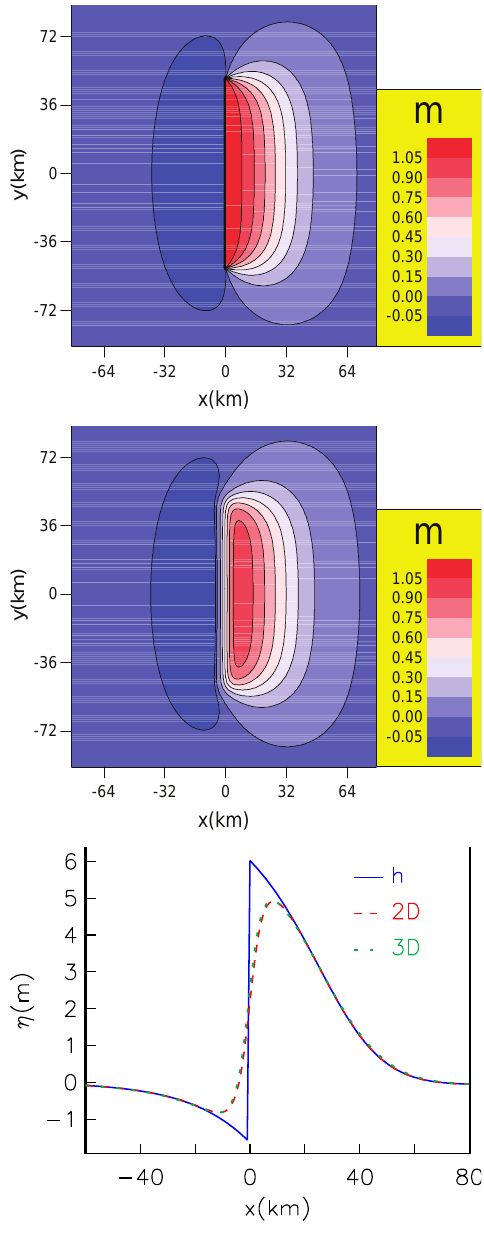
Fig. 4. The surface elevation along the y = 0 transect after 30min . Dispersive results with initial conditions obtained with and without application of the Green function of Kajiura are marked h.o. and h.o. ? , respectively. Also the LSW solution is included for compari- son. Waves are propagating to the right.